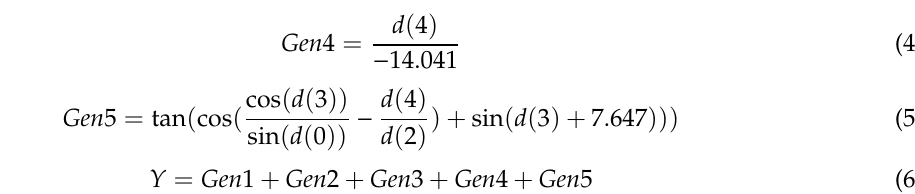
Table 3. The results of various gene expression programming (GEP) models for prediction of PPV. Model No. Train Test Train Rate Test Rate Train Test Train Rate Test Rate R 2 RMSE Model No. R 2